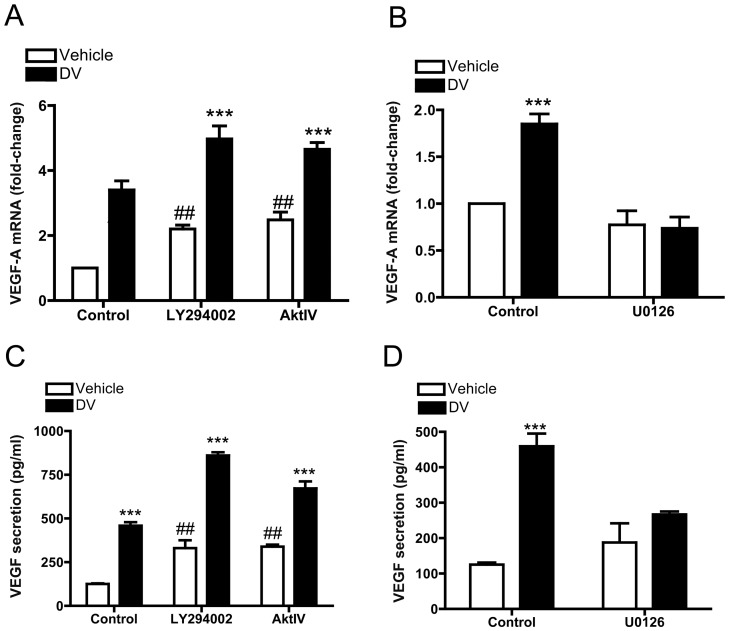
DV increases VEGF-A at mRNA and protein level through an ERK-dependent pathway.(A) qPCR analysis of VEGF-A mRNA in BECs +/− DV and +/−10 µM LY294002 or 10 µM AktIV. GAPDH was used as internal control. N = 3, ***P<0.001 in comparison between DV-treated and untreated cells, ##
P<0.01 in comparison between inhibitors and untreated groups. (B) Similar analysis as in (A) demonstrating that 10 µM U0126 (MEK inhibitor) treatment significantly blunted DV-induced VEGF-A mRNA up-regulation. N = 3. ***P<0.001 in comparison between DV-treated and untreated cells. (C) Secreted VEGF ELISA profile from BECs following treatment with DV, LY294002, or AktIV alone or in combination Note the significant up-regulation of secreted VEGF following DV, LY294002 or AktIV treatment. N = 3, ***P<0.001 in comparison between DV-treated and untreated cells, ##
P<0.01 in comparison between LY and AktIV treated groups versus untreated group. (D) U0126 treatment significantly inhibited VEGF secretion from BECs following DV treatment. N = 3. ***P<0.001 in comparison between DV-treated and untreated cells.